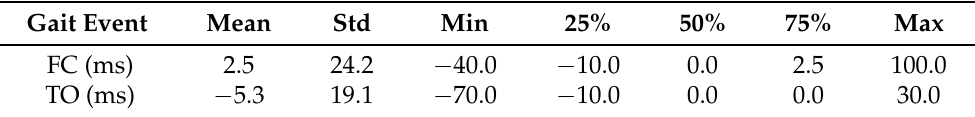
Figure 3. The precision, recall, and F1-score for FC and TO identification. Table 1. The prediction time (ms) of FC and TO before the true gait events. A positive value represents the predicted event prior to the true event, while a negative value indicates that the predicted event occurs after the true event.